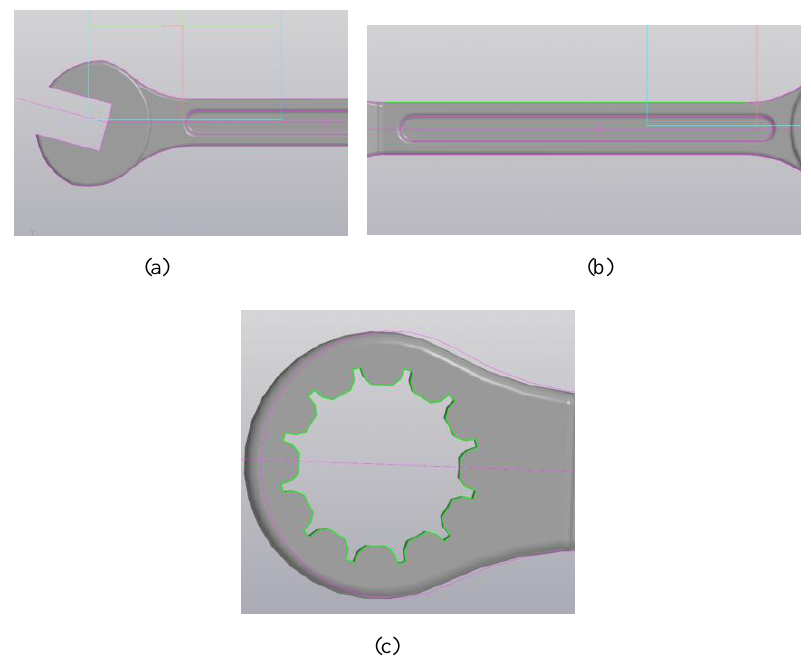
Fig. 3. Parametric modeling of a part. (a) Changing the tilt of the open mouth, (b) Change the length of the recess, (c) The diameter